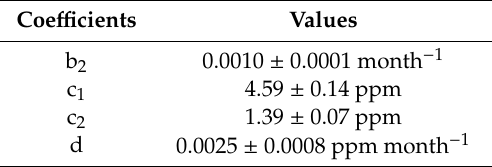
Table 1. Values of the coefficients in Equation (2). Table 2. Values of significant coe ffi cients in Equation